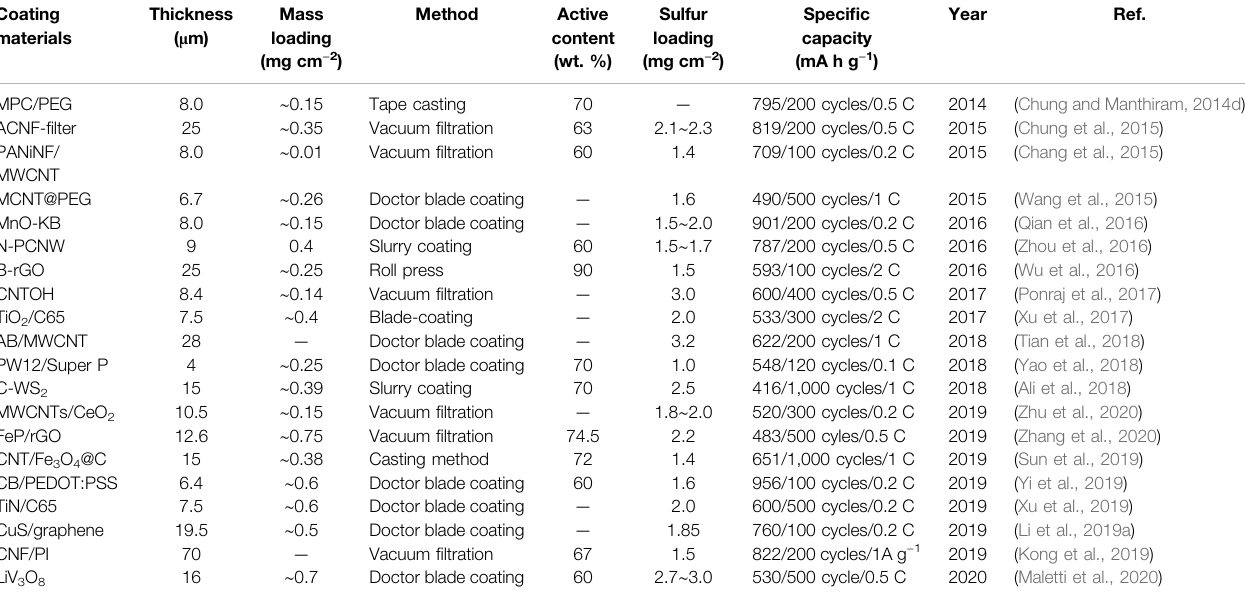
TABLE 1 | Overview of the studies about modi fi ed separators with dual-working mechanisms for LSBs. Coating